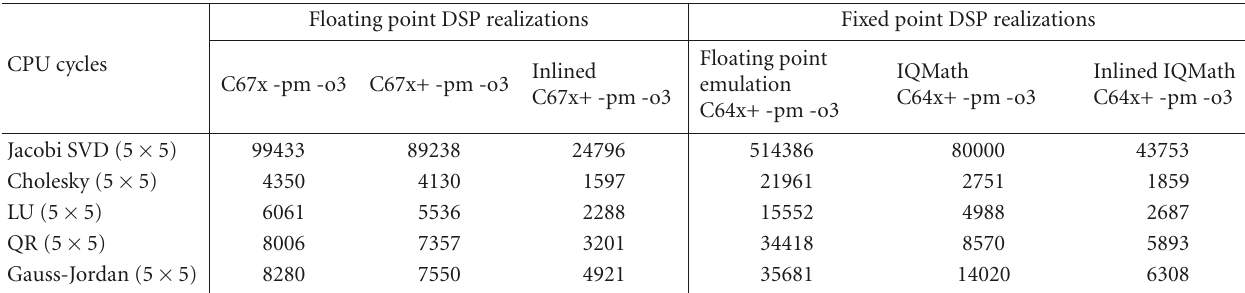
Table 5: Cycle count relative to selected numerical linear algebra implementations.